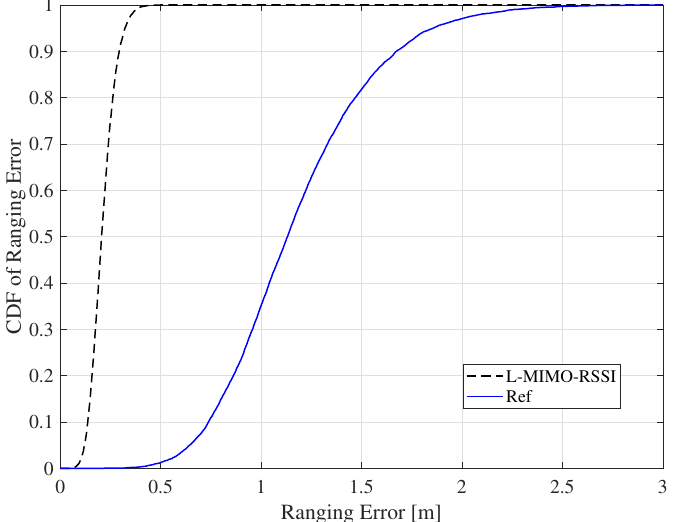
Figure 10. The CDF of ranging RMSE for the proposed algorithm for the LOS environment and the co-polarized antenna configuration.